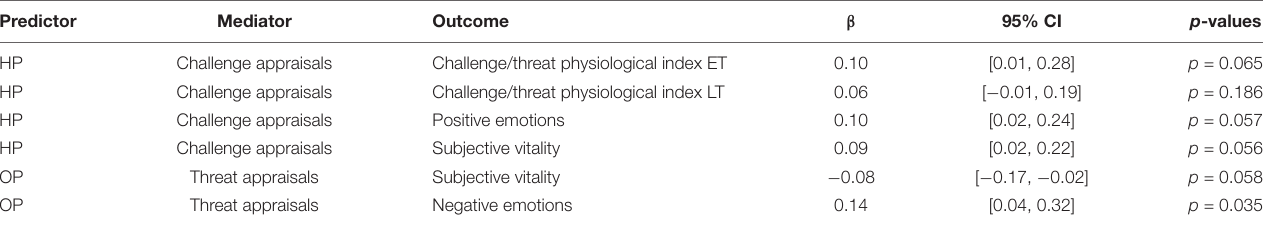
FIGURE 1 | Results of the Path Analysis. Standardized path coefficients are presented. For clarity concerns, covariances are not presented. N = 55. ET, education task; LT, leisure task. ∗ p < 0.05 and ∗∗ p < 0.01. TABLE 2 | Bootstrap estimates of the indirect effects and their associated bias-corrected 95% confidence